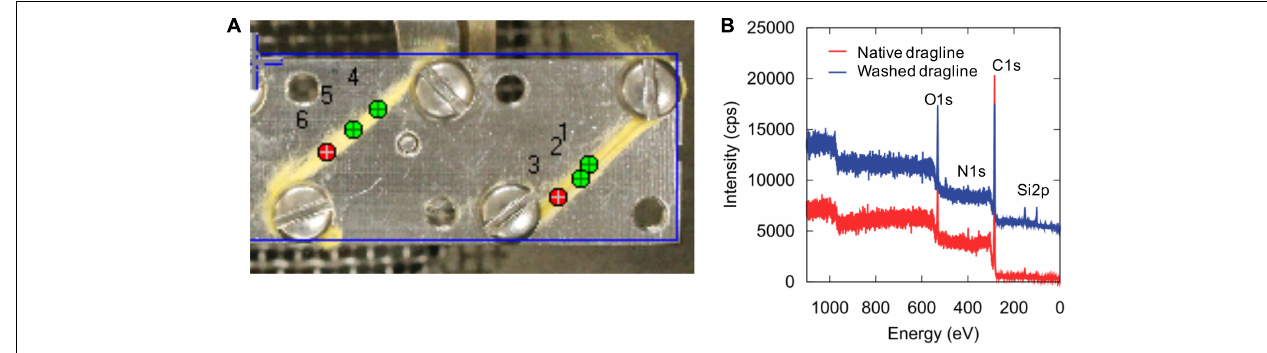
FIGURE 3 | XPS sample setting (A) and wide-scan spectra (B) of native spider dragline (red) and spider dragline after ether wash